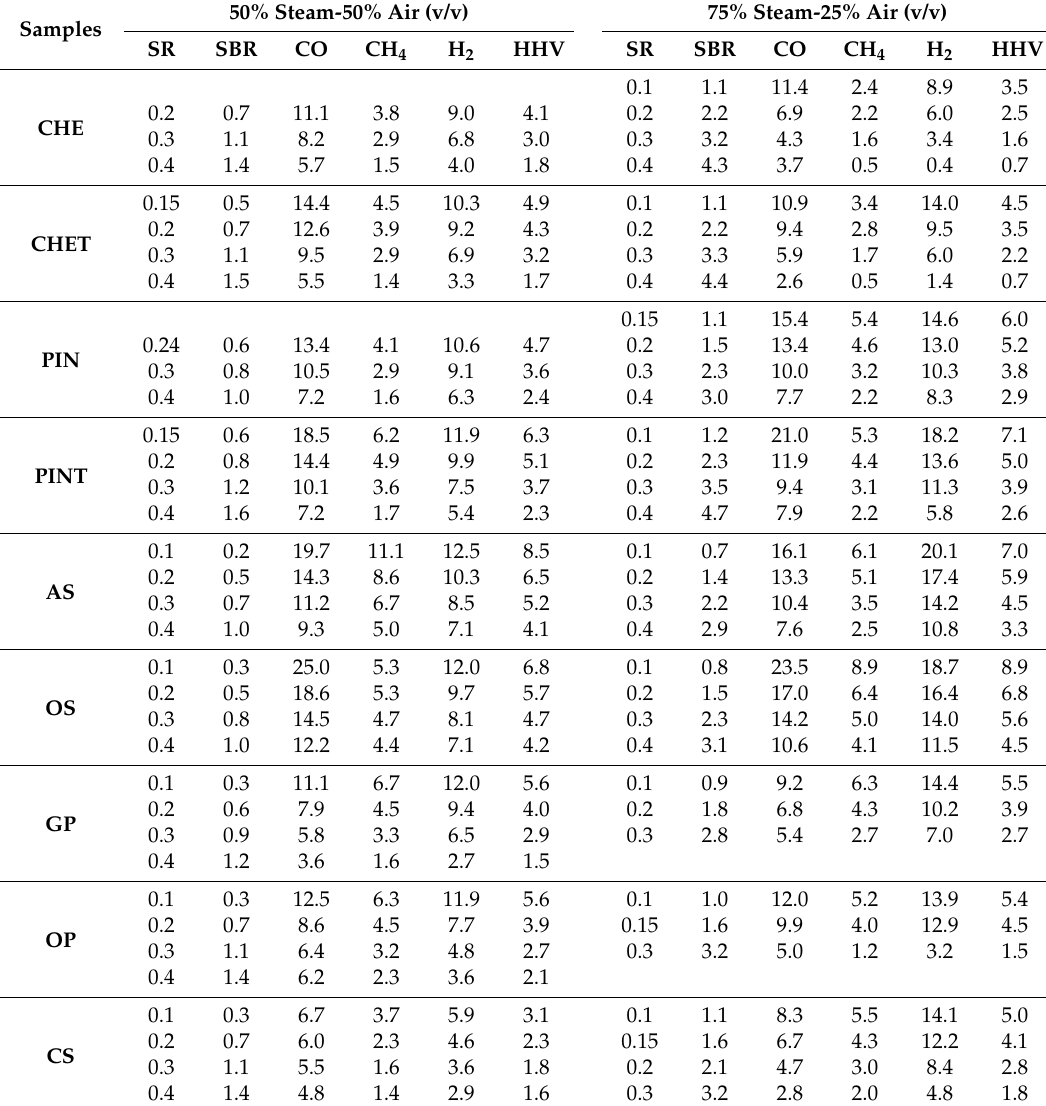
Table 2. Gaseous emissions (vol. %) and HHV (in MJ/Nm 3 ) obtained for the studied samples.